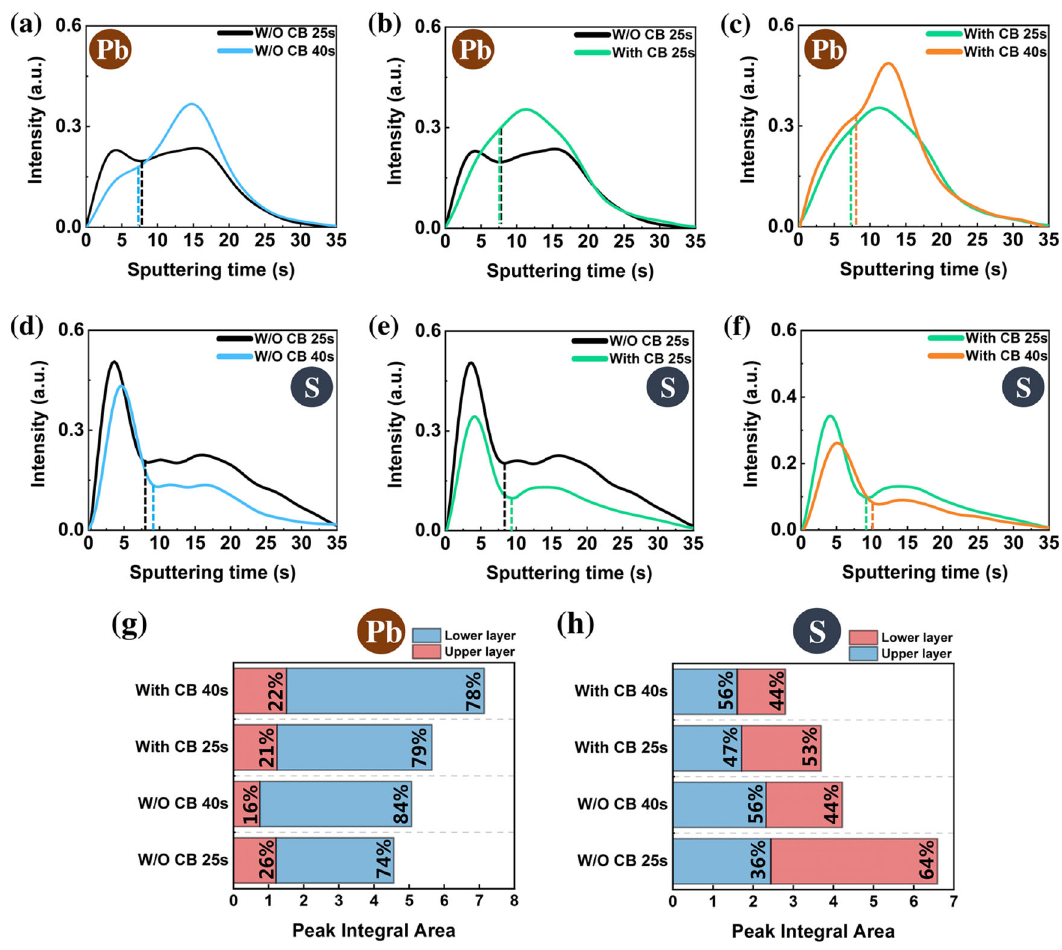
Fig. 2| GD-OES investigationofspincoating anddrippingprocesses. Evolution of GD-OES elementaldepthpro fi les. a – c lead (Pb) and d – f sulfur (S)inthe CsFAPI/ AKC perovskite precursorlayerupon spin coating (sputtering erosion from topto bottom).Theinterfacebetweentheupperandlowerlayersisindicatedbyadashed